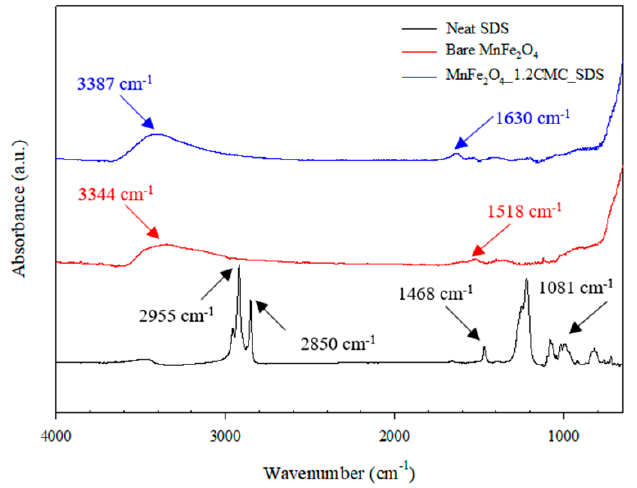
Figure 1. FT-IR spectra of the neat SDS surfactant, bare MnFe 2 O 4 , and MnFe 2 O 4 _1.2CMC_SDS ferrite nanoparticles.